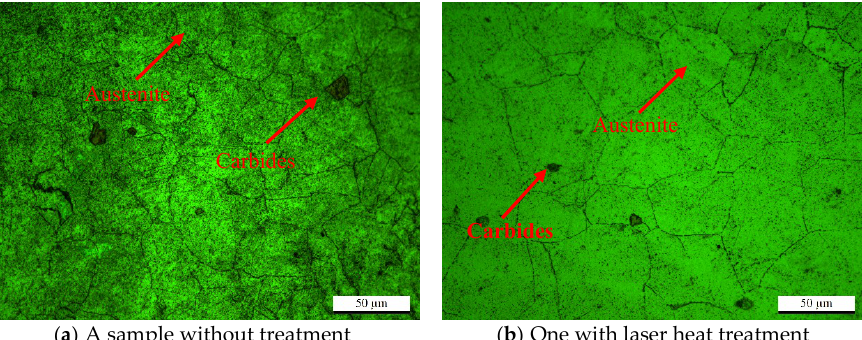
Figure 3. Microstructure diagram of alloy sample.